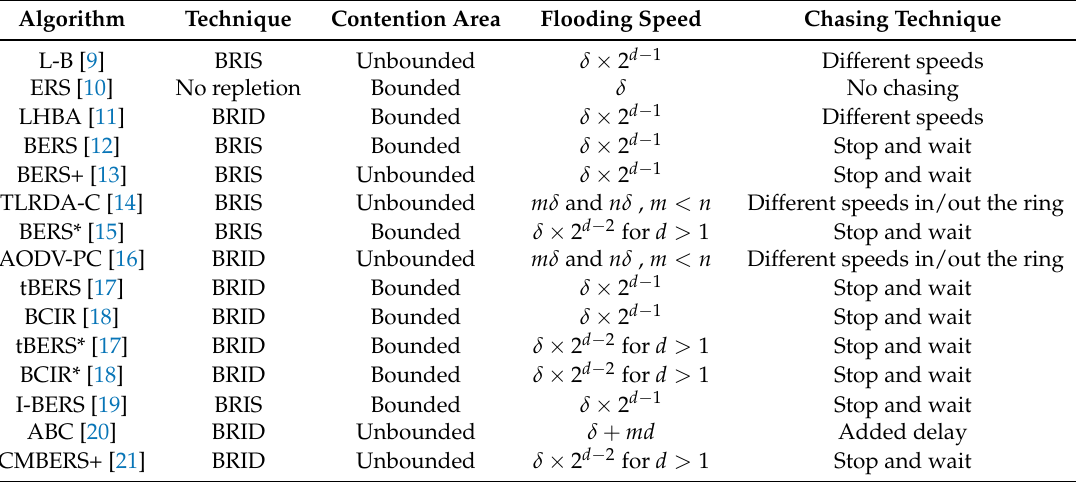
Table 1. Flooding contention